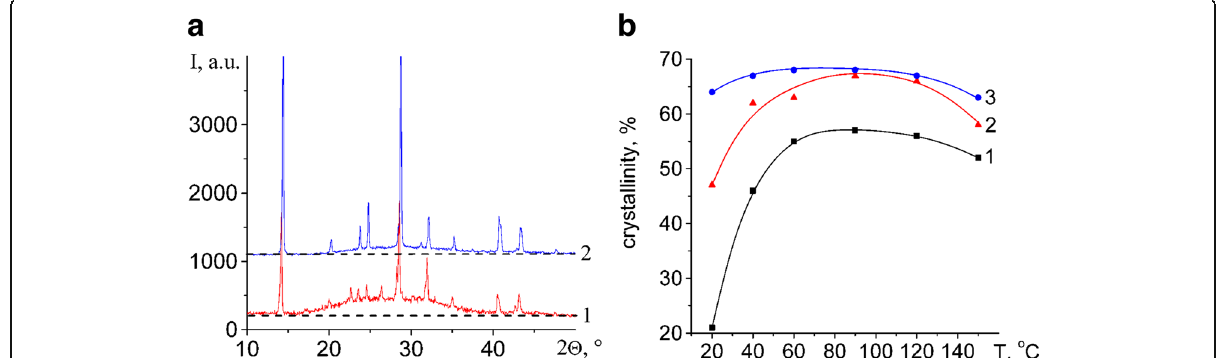
Fig. 2 a Comparison of XRD patterns of organic-inorganic films CH 3 NH 3 PbI 2.98 Cl 0.02 synthesized at ratios of PbI 2 and CH 3 NH 3 I deposited at 20 °C (1) and 90 °C (2). b Film crystallinity as a function of deposition temperature of organic-inorganic films CH 3 NH 3 PbI 2.98 Cl 0.02 synthesized at ratios of PbI 2 and CH 3 NH 3 I 1:1 (1), 1:2 (2), and 1:3 (3) (lines are drawn in for clarity)